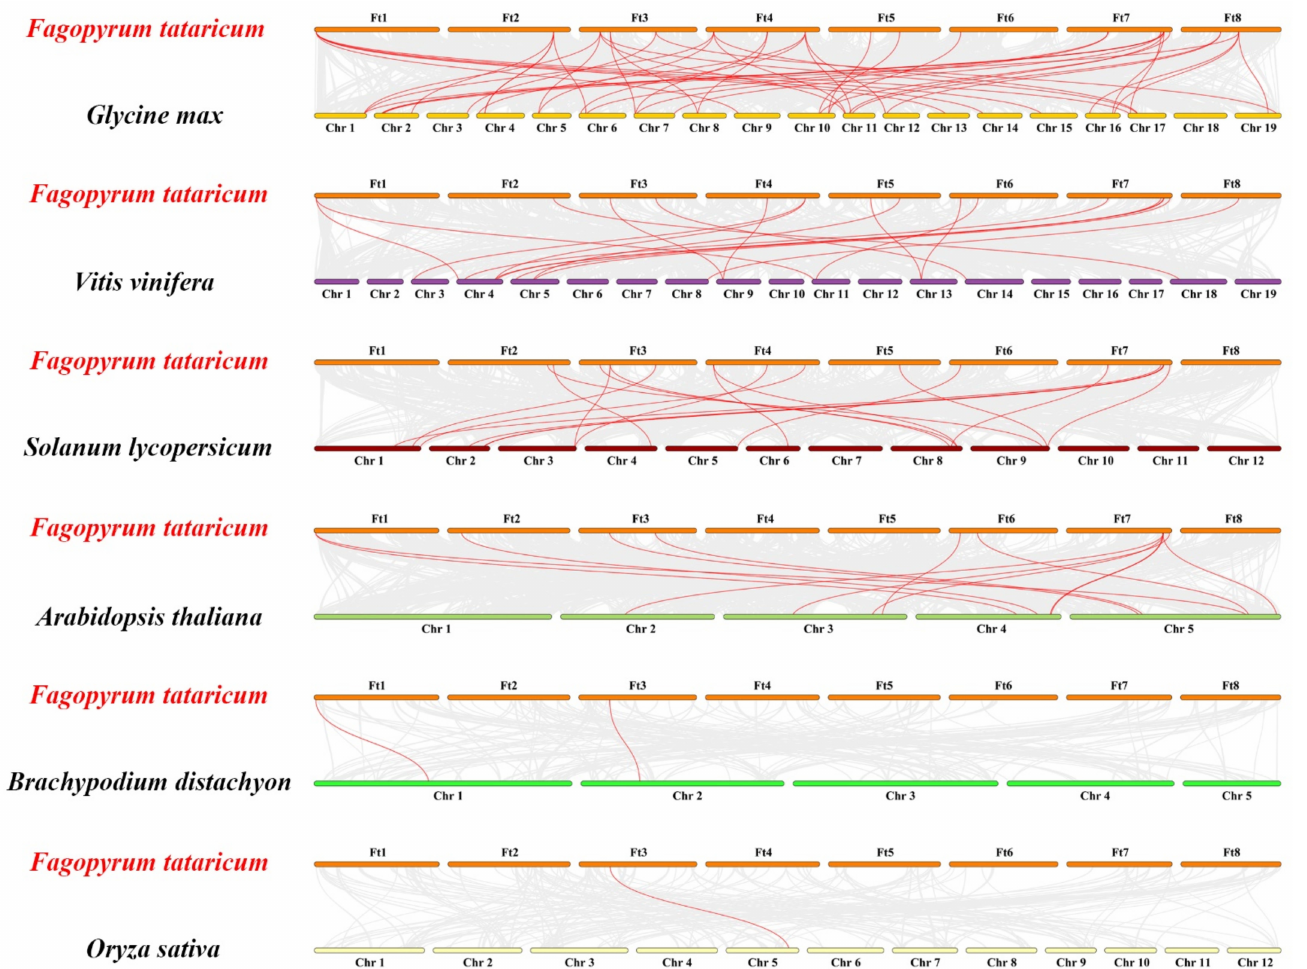
Figure 5. Collinear analysis of GATA genes between Fagopyrum tataricum and six different plants ( Glycine max , Vitis vinifera , Solanum lycopersicum, Arabidopsis thaliana, Brachypodium distachyon , and Oryza sativa ). The gray lines between F. tataricum and other plants represent collinearity in wide regions of the genomes, and red lines show the orthologous relationship of GATA genes. Ft represents the chromosome number of F. tataricum , and Chr represents the chromosome number of the six other